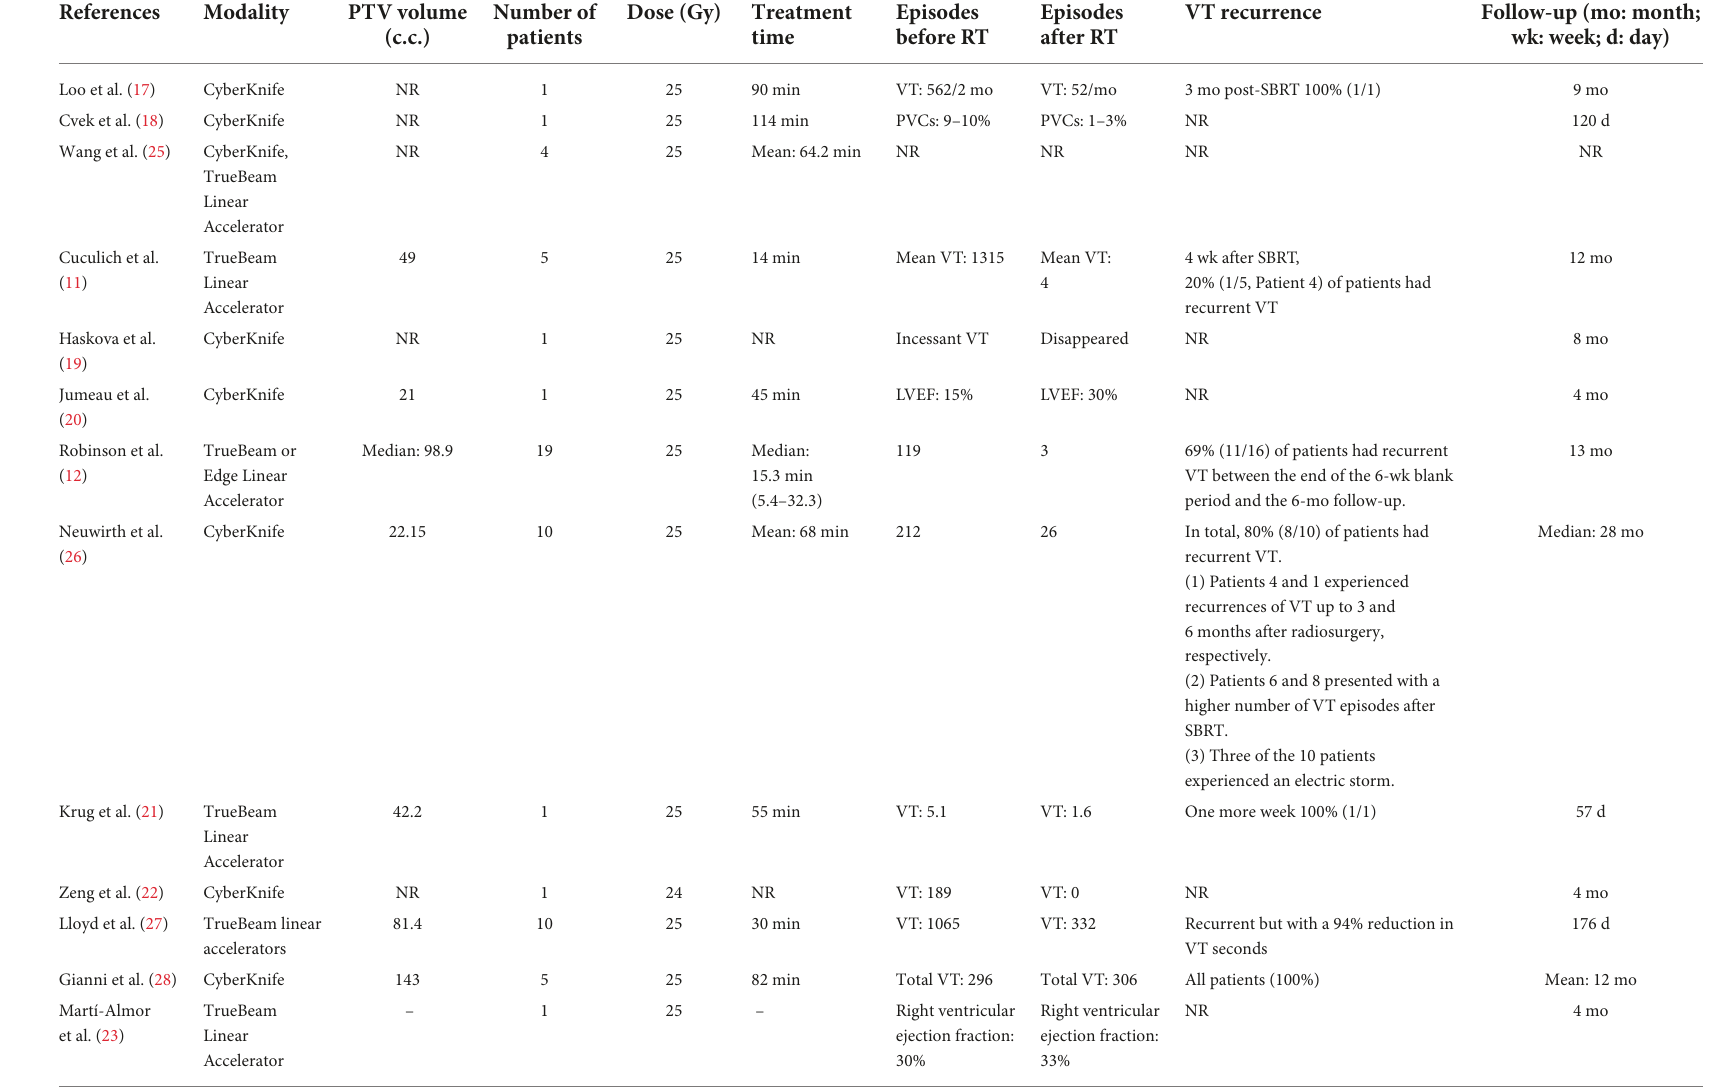
TABLE 2 Comparison of a patient with refractory VT treated with SBRT using a dose of 12 Gy at the Far Eastern Memorial Hospital (FEMH) with a selected published series of patients treated with